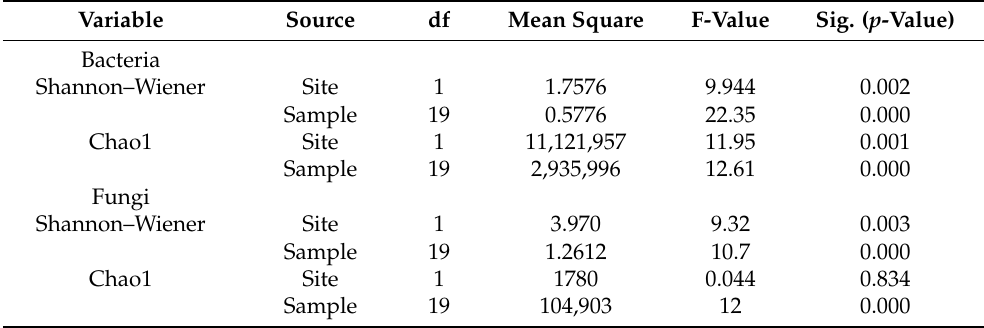
Table 2. Difference significance for whole sites or sample level on microbial diversity and richness